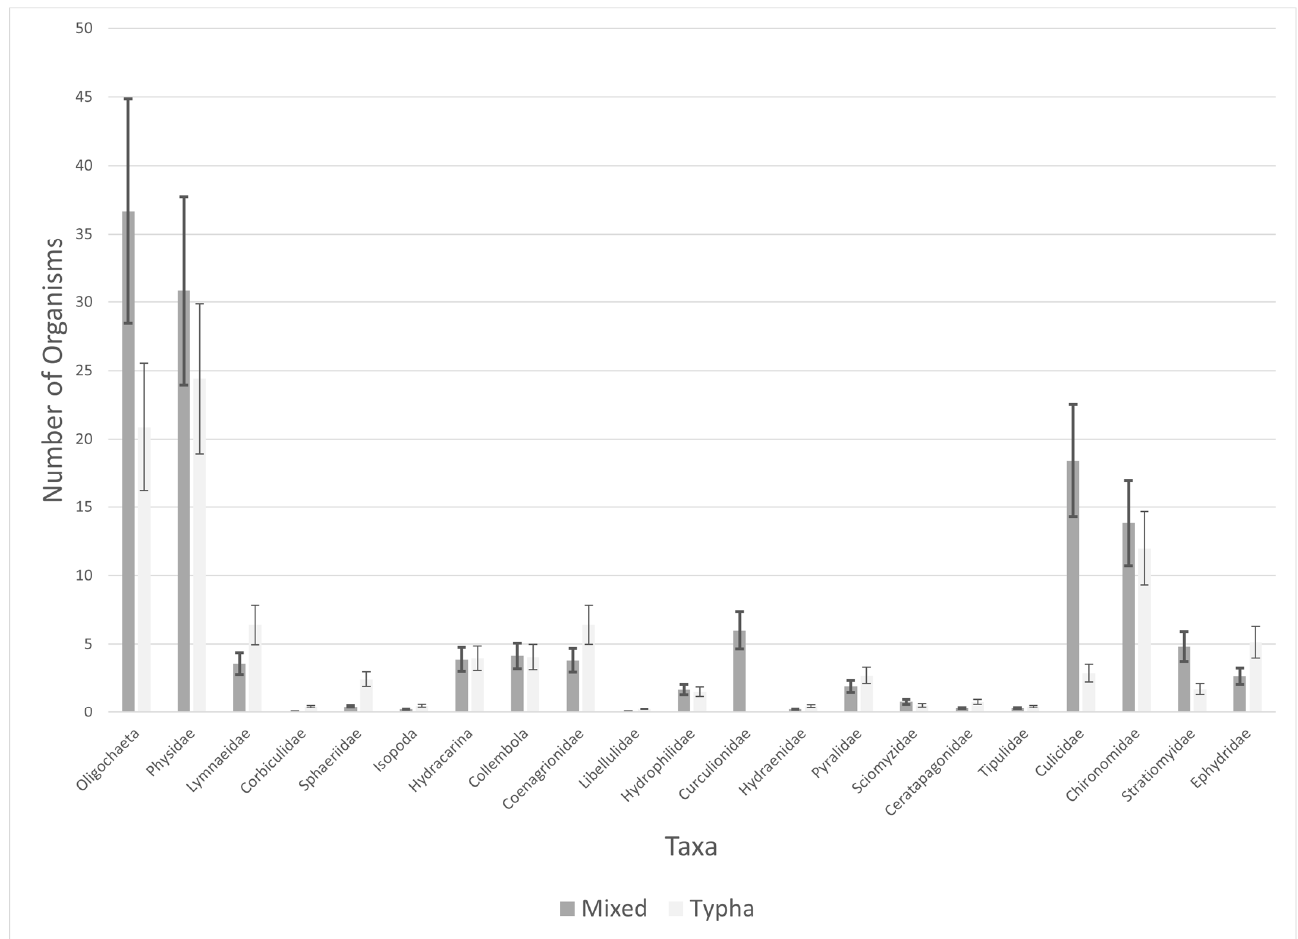
Figure 6. Average number of organisms by taxa by vegetation with standard error lines.